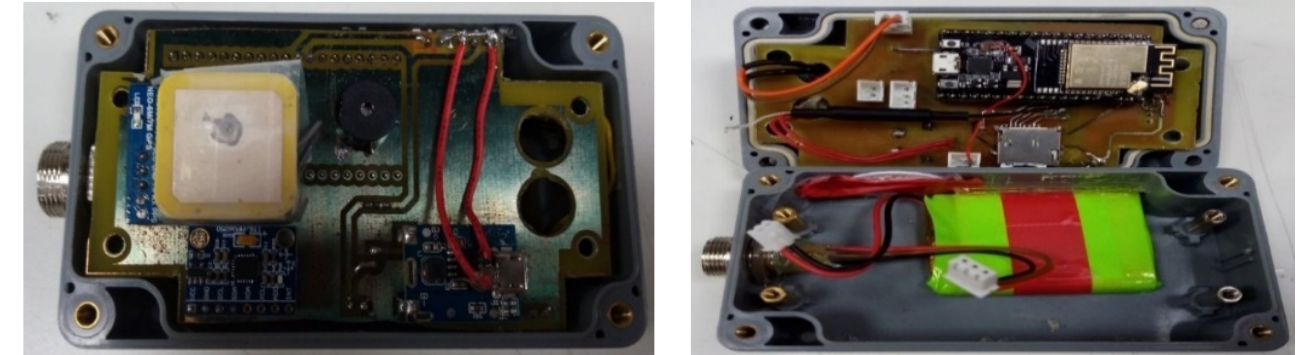
Figure 17. Set-top box circuit design.